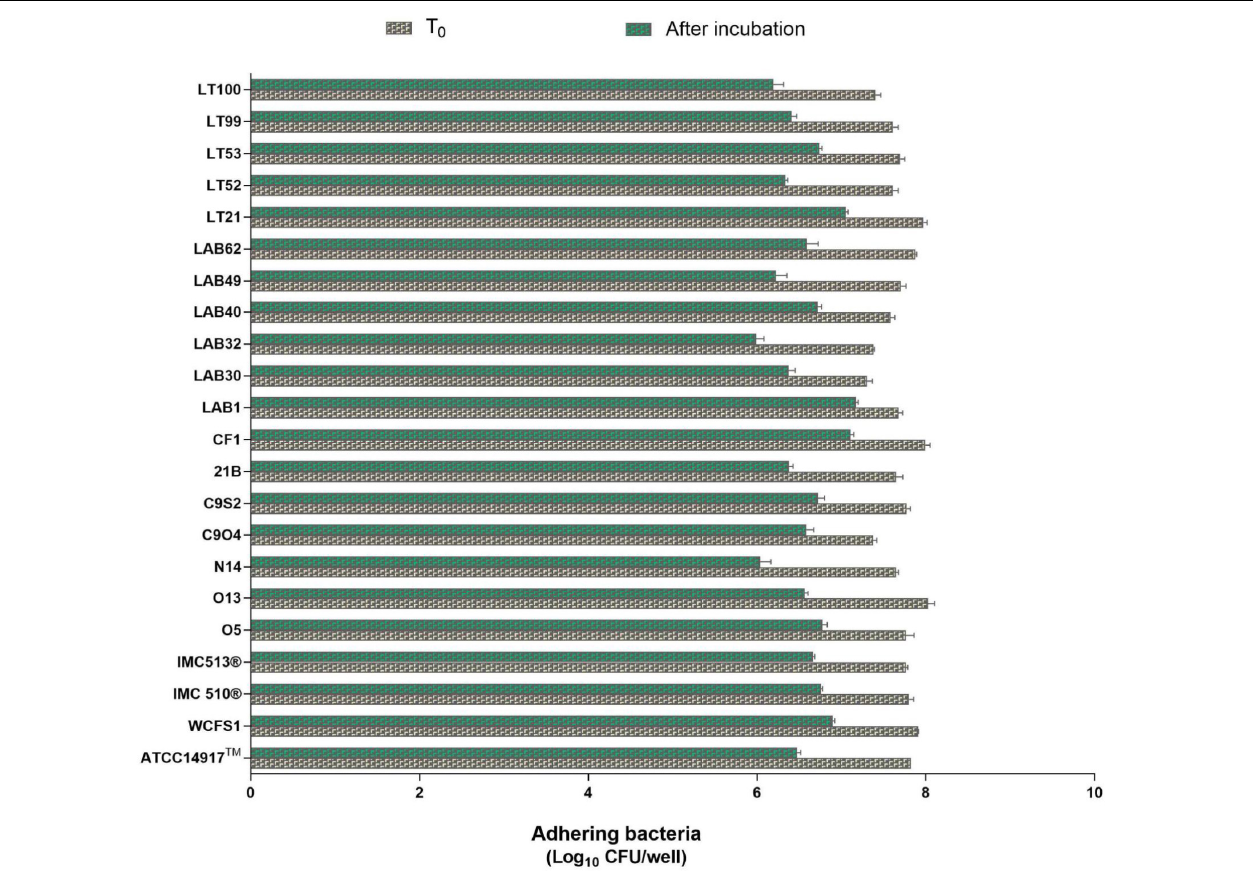
FIGURE 6 | Enumeration of adhering Lb. plantarum cultures to mucin. Values are expressed as mean ± SEM from three biological replicates and are reported as log 10 CFU/well. A level of p < 0.0001 was considered statistically